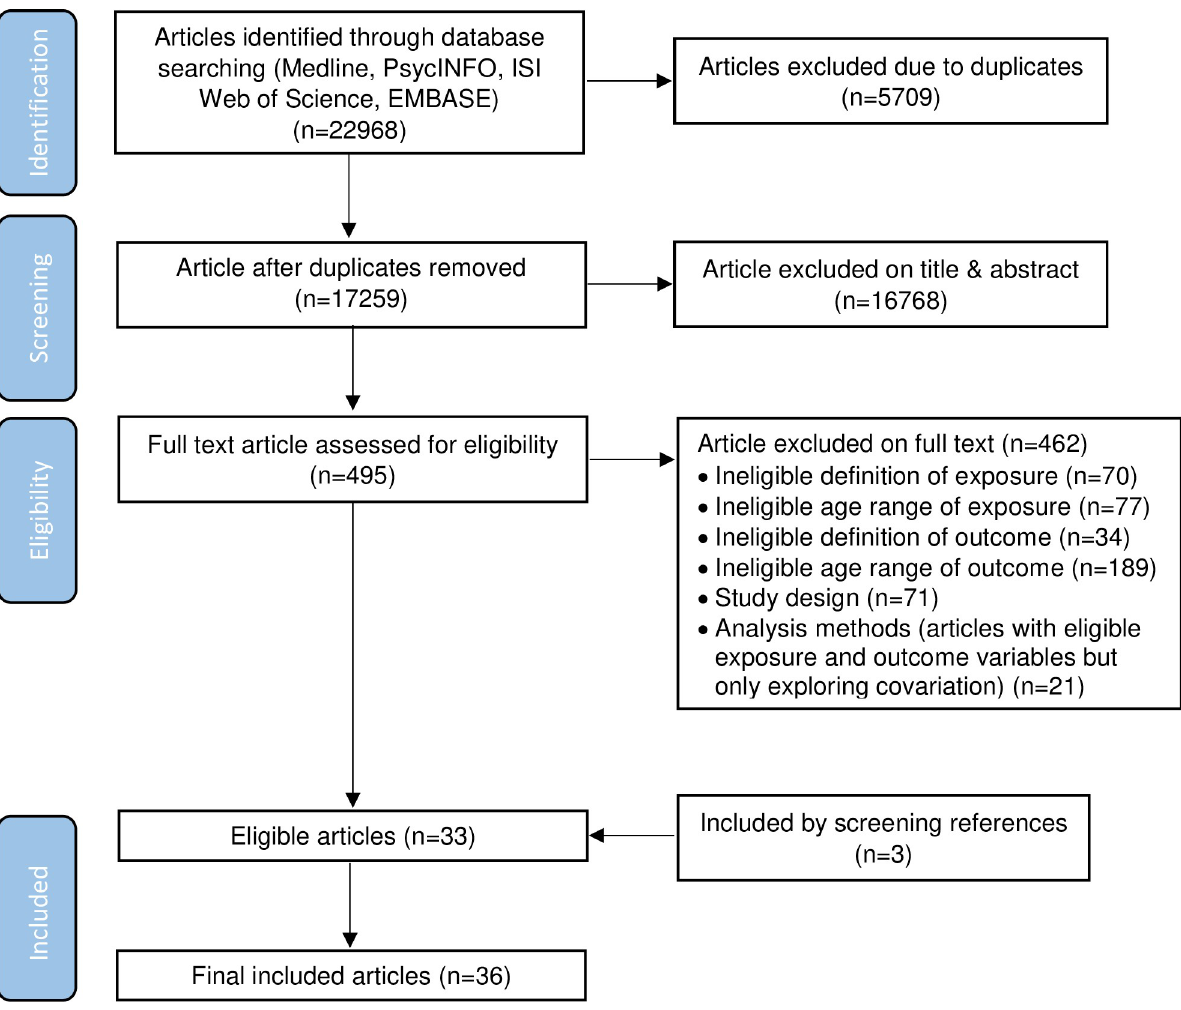
Fig 1. Flow chart of the screening process. missing data. Associations were extracted if they reflected the total association of the relation- ship. For example, if depression at age 7 and depression at age 16 were adjusted for in the model simultaneously (e.g. outcome = a+b1 � depression at age 7+b2 � depression at age 16), then the coefficient b2 can be interpreted as total association between depression at age 16 and alcohol, which was not confounded by previous depression status (and thus was extracted), while the coefficient b1 was the controlled direct association between depression at age 7 and the outcome not through later depression status (and thus was not extracted). See more defini- tions in Pearl(2001) [79]. In addition, some studies reported several associations for the same exposure-outcome set, so other rules were devised to avoid duplicate associations: continuous measures (versus categorical), self-report (versus parent or teacher report), most properly adjusted result, unstandardized betas (versus standardised), whole population (versus sub- population). Discrepancies were discussed and agreed upon before extracting information from all included articles.